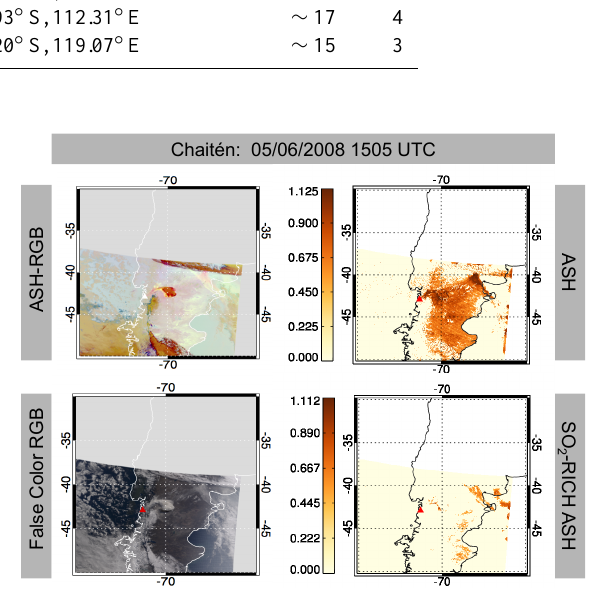
Table 1. Seven volcanic eruptions and their corresponding time, location, plume height (km), and explosivity. Volcano Date of eruption Location Plume height VEI Kasatochi 7 Aug 2008 52.177 ◦ N, 175.508 ◦ W Okmok 12 Jul 2008 53.43 ◦ N, 168.13 ◦ W Grímsvötn 21 May 2011 Chaitén 6 May 2008 42.833 ◦ S, 72.646 ◦ W Puyehue-Cordón Caulle 4 Jun 2011 Kelut